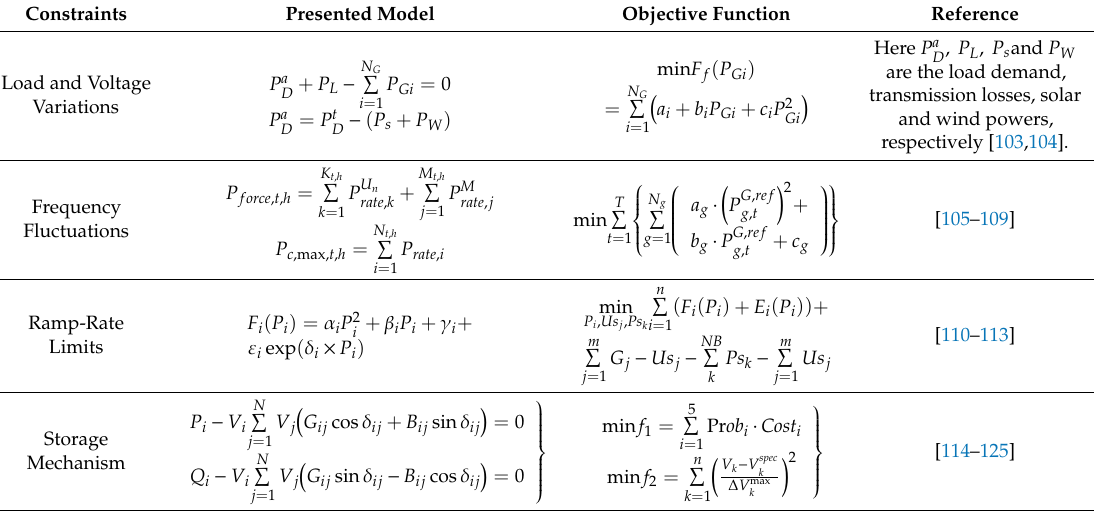
Table 6. Constraints and their solutions for optimal economic (OED) of Renewable Energy Sources